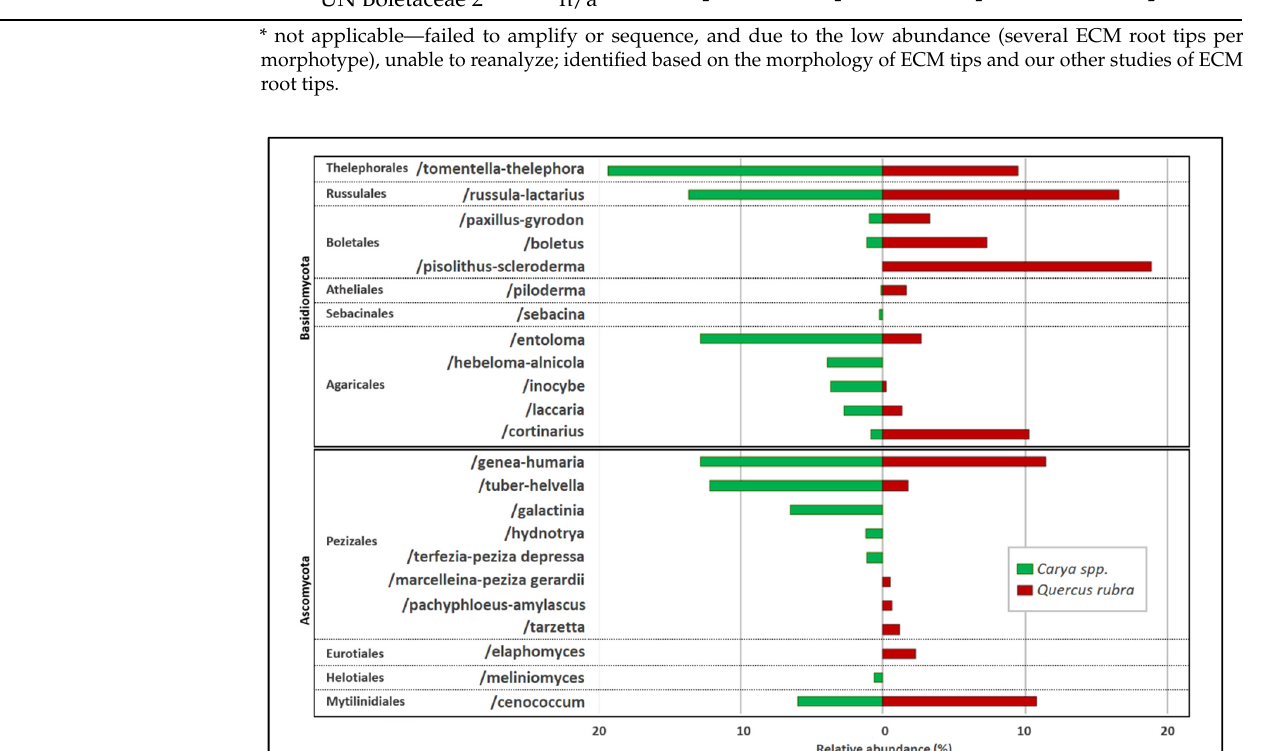
Figure 3. Relative abundance of exploration types of ectomycorrhizas on Carya and Q. rubra roots based on the classification proposed by Agerer [43]: C—contact, SD—short-distance, C/SD—contact or short distance; MDS—medium-distance smooth, MDF—medium-distance fringe, and LD—long- distance exploration type.